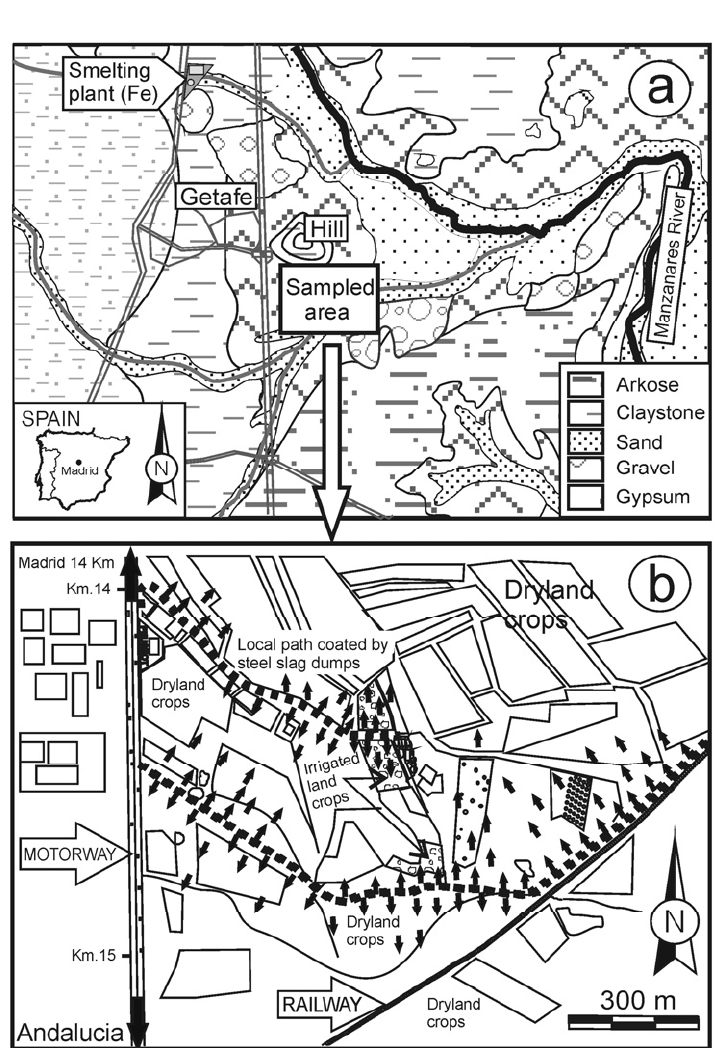
Fig. 1 – (a) Geological sketch of the studied and sampled area. (b) Location map of the area affected by the presence of steel-slag